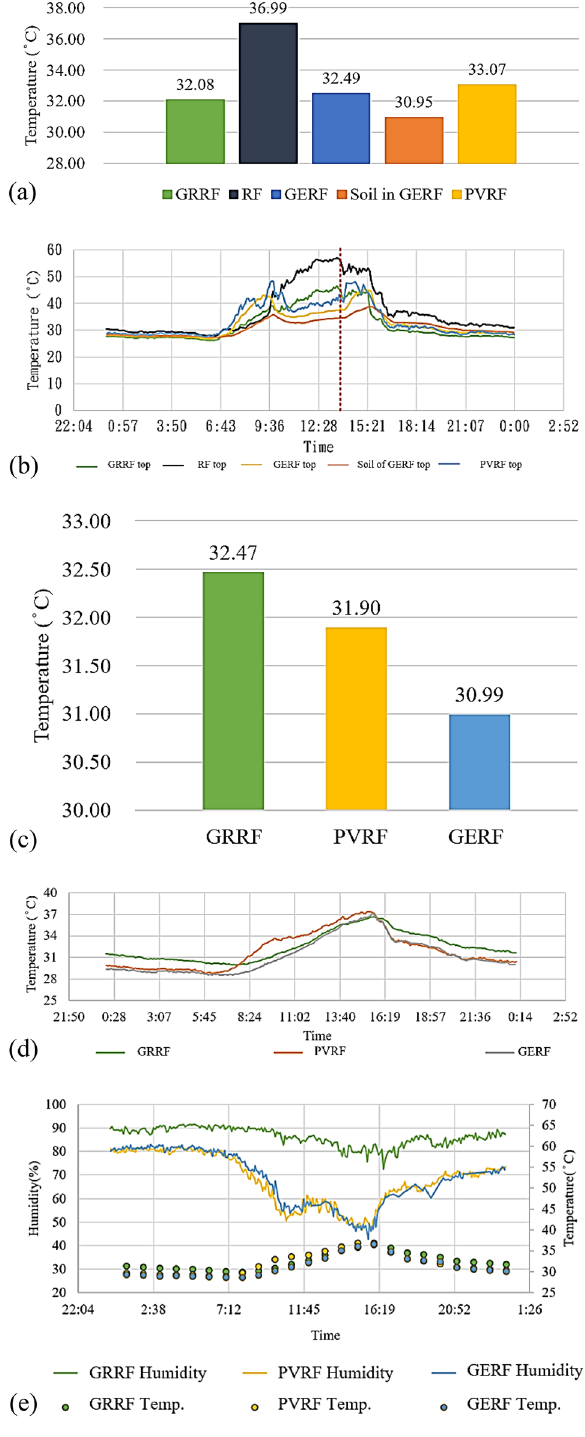
Figure 9. ( a ) Mean surface temperatures, ( b ) surface temperature changes, ( c ) mean indoor temperatures, ( d ) indoor temperature changes, and ( e ) indoor temperature and humidity comparisons for April